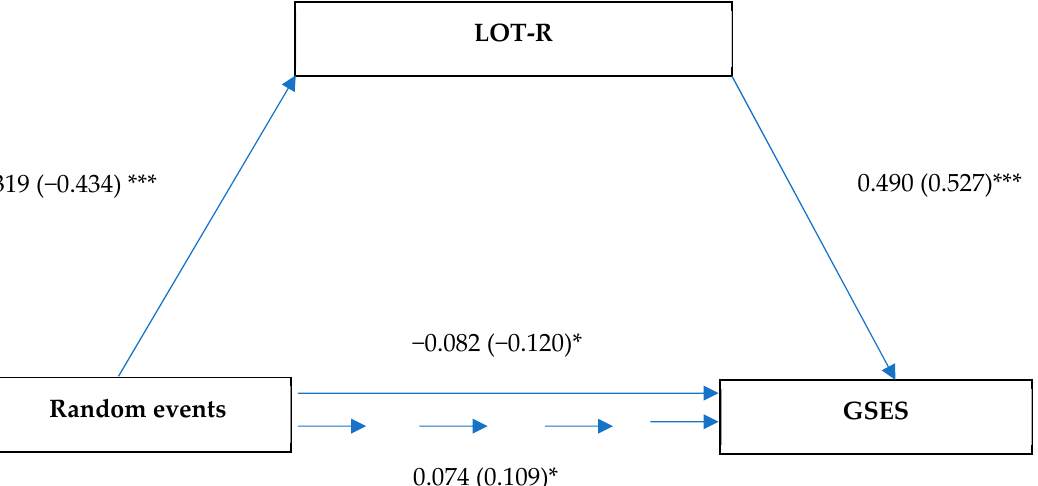
Figure 5. Model of relationships between health locus of control (random events), dispositional optimism, and self-efficacy. Unstandardized coefficient (standardized coefficient); * p < 0.05; and *** p < 0.001.